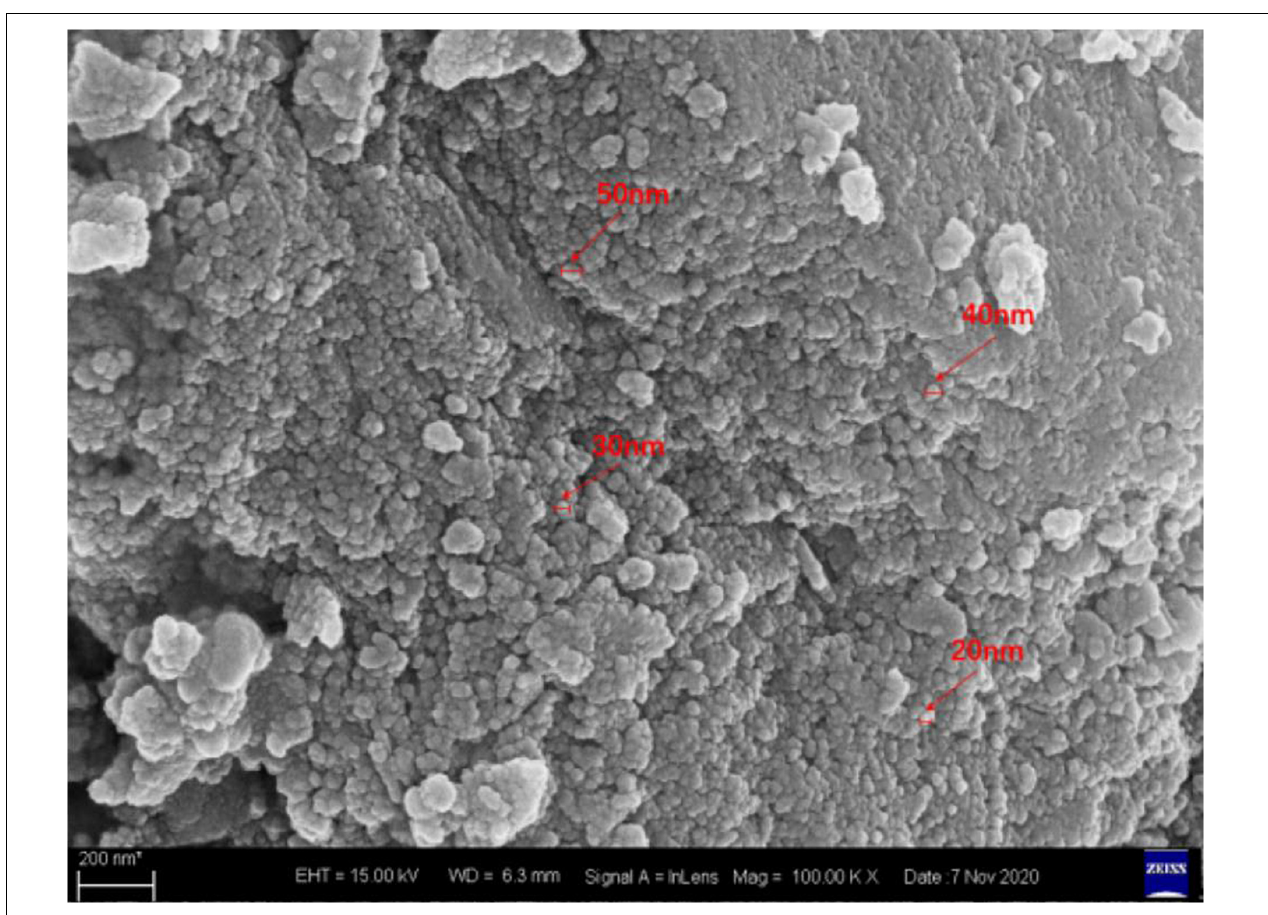
FIGURE 5 | SEM image of the Al 2 O 3 carrier particle